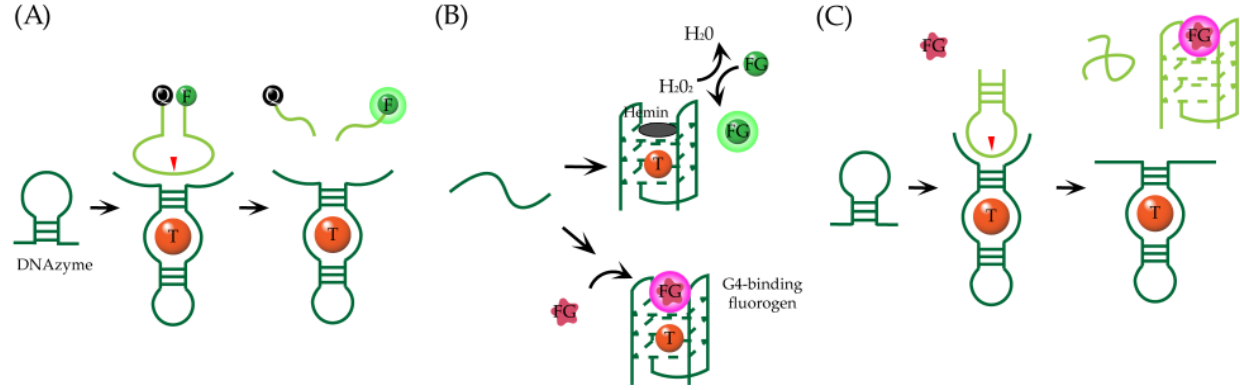
Figure 2. Schematic overview of fluorogenic aptazymes for the detection of small targets (T): ( A ) RNA-cleaving DNAzymes, ( B ) hemin (or FG)-conjugated G4 DNAzymes, and ( C ) aptazymes by combining ( A ) and ( B ) Red arrows indicate RNA- cleaving sites. RNA substrates are linked to F-to-Q in ( A ) or consist of a short fragment of G4-DNAzyme sequence in ( C ). The FL signal from FG can be generated via H 2 O 2 -mediated oxidation or upon binding to the G4 structure in ( B ). Additionally, these DNAzyme-based aptasensors can be extended to different formats by integrating other nucleic acids or nanomaterials. G4, guanine (G)-quadruplex; FG,